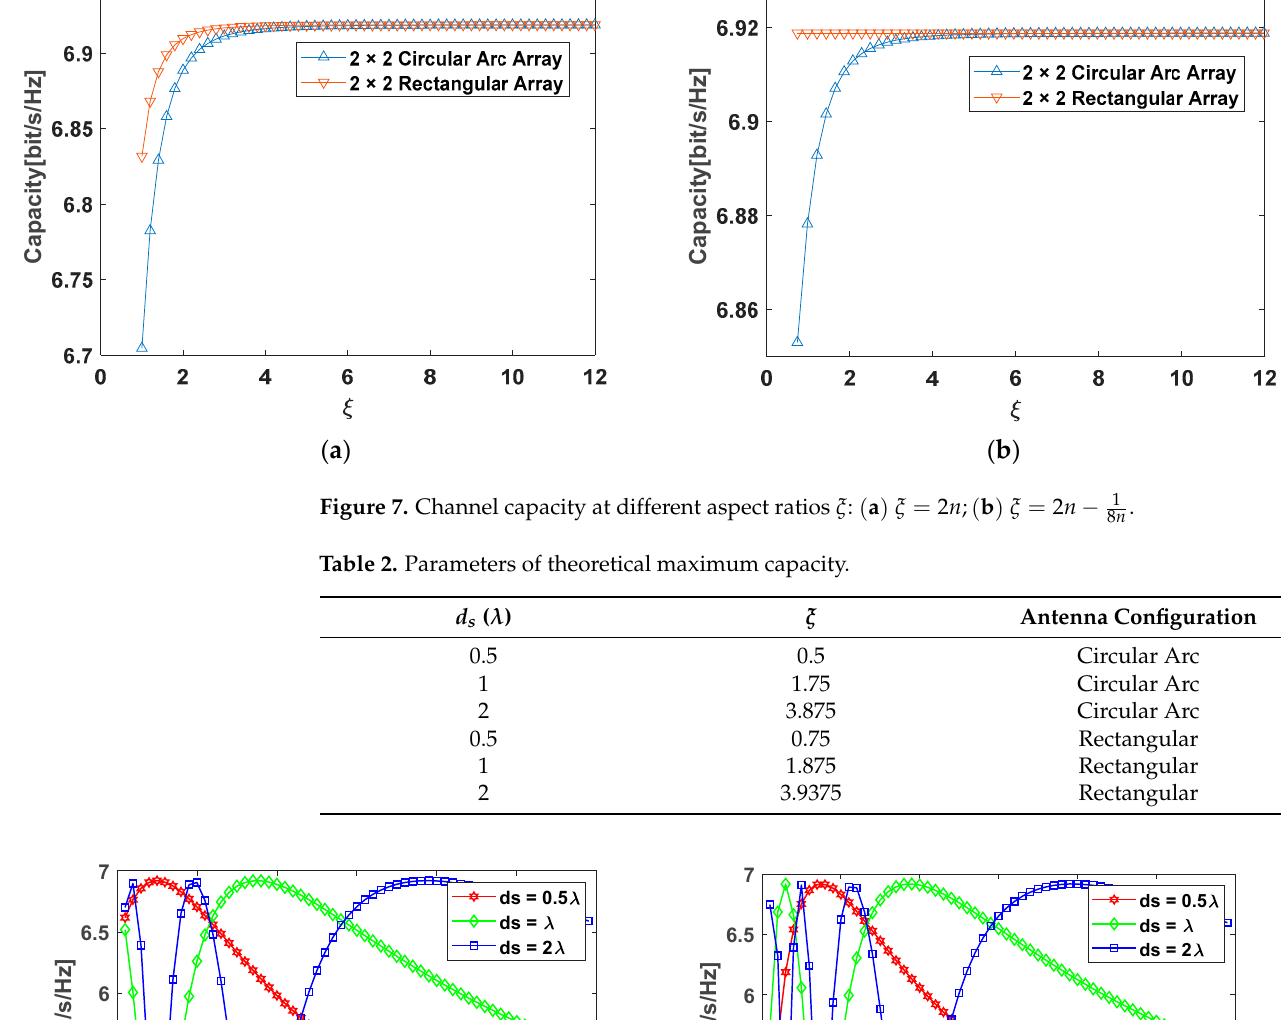
Table 2. Parameters of theoretical maximum capacity.